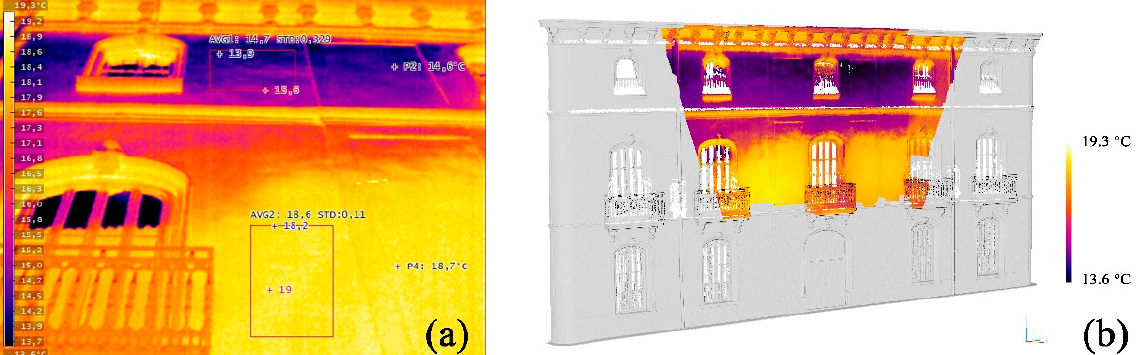
Figure 19. ( a ) TIR image of the northern façade upper area, evidencing a remarkable thermal discrepancy between the second and the third floor (approximately 5–6 °C); ( b ) 3D data integration between the LiDAR point cloud and TIR images through SfM photogrammetric processes, evidencing a thermal discrepancy between the second floor and third floor.